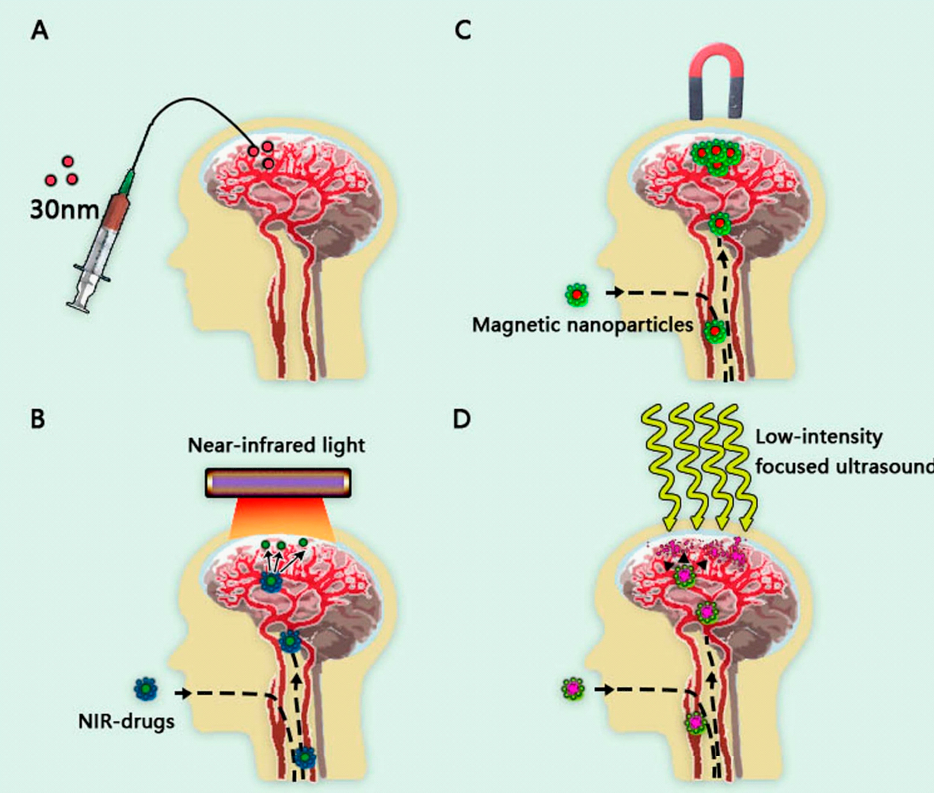
Figure 4. Direction of drug development for Alzheimer’s disease. ( A ). Drug delivery via brain ECS. ( B ). Magnetic nanoparticles [223]. ( C ). Near-infrared photosensitive nanomedicines [230]. ( D ). Com-